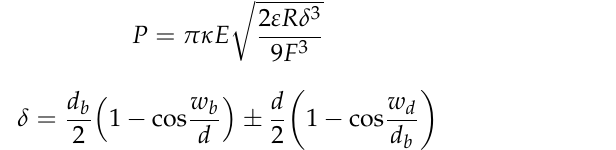
Figure 5. The scratch defect model of rolling bearing.